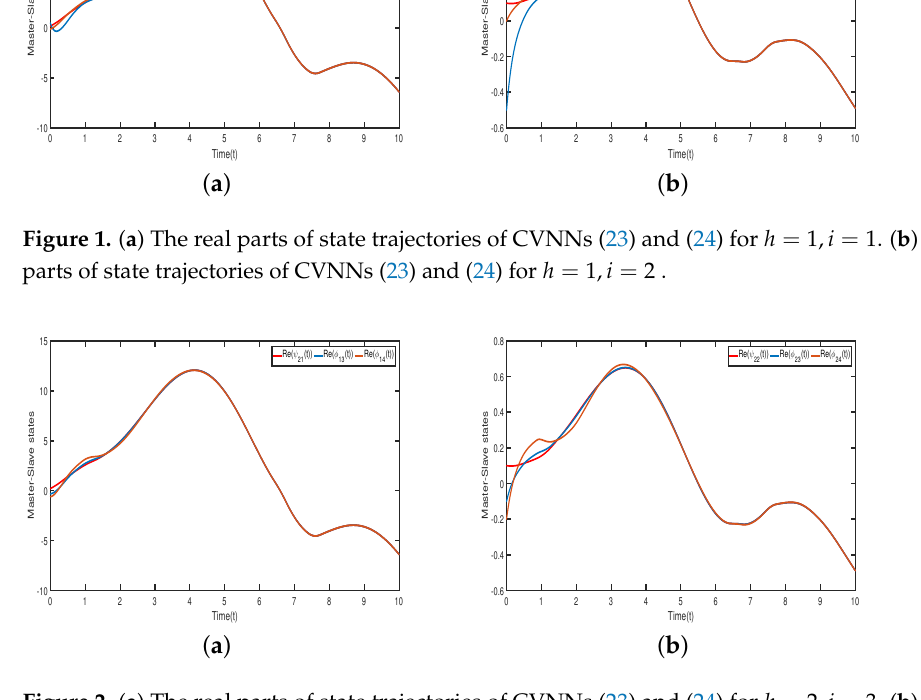
Figure 2. ( a ) The real parts of state trajectories of CVNNs (23) and (24) for h = 2, i = 3. ( b ) The real parts of state trajectories of CVNNs (23) and (24) for h = 2, i = 4.